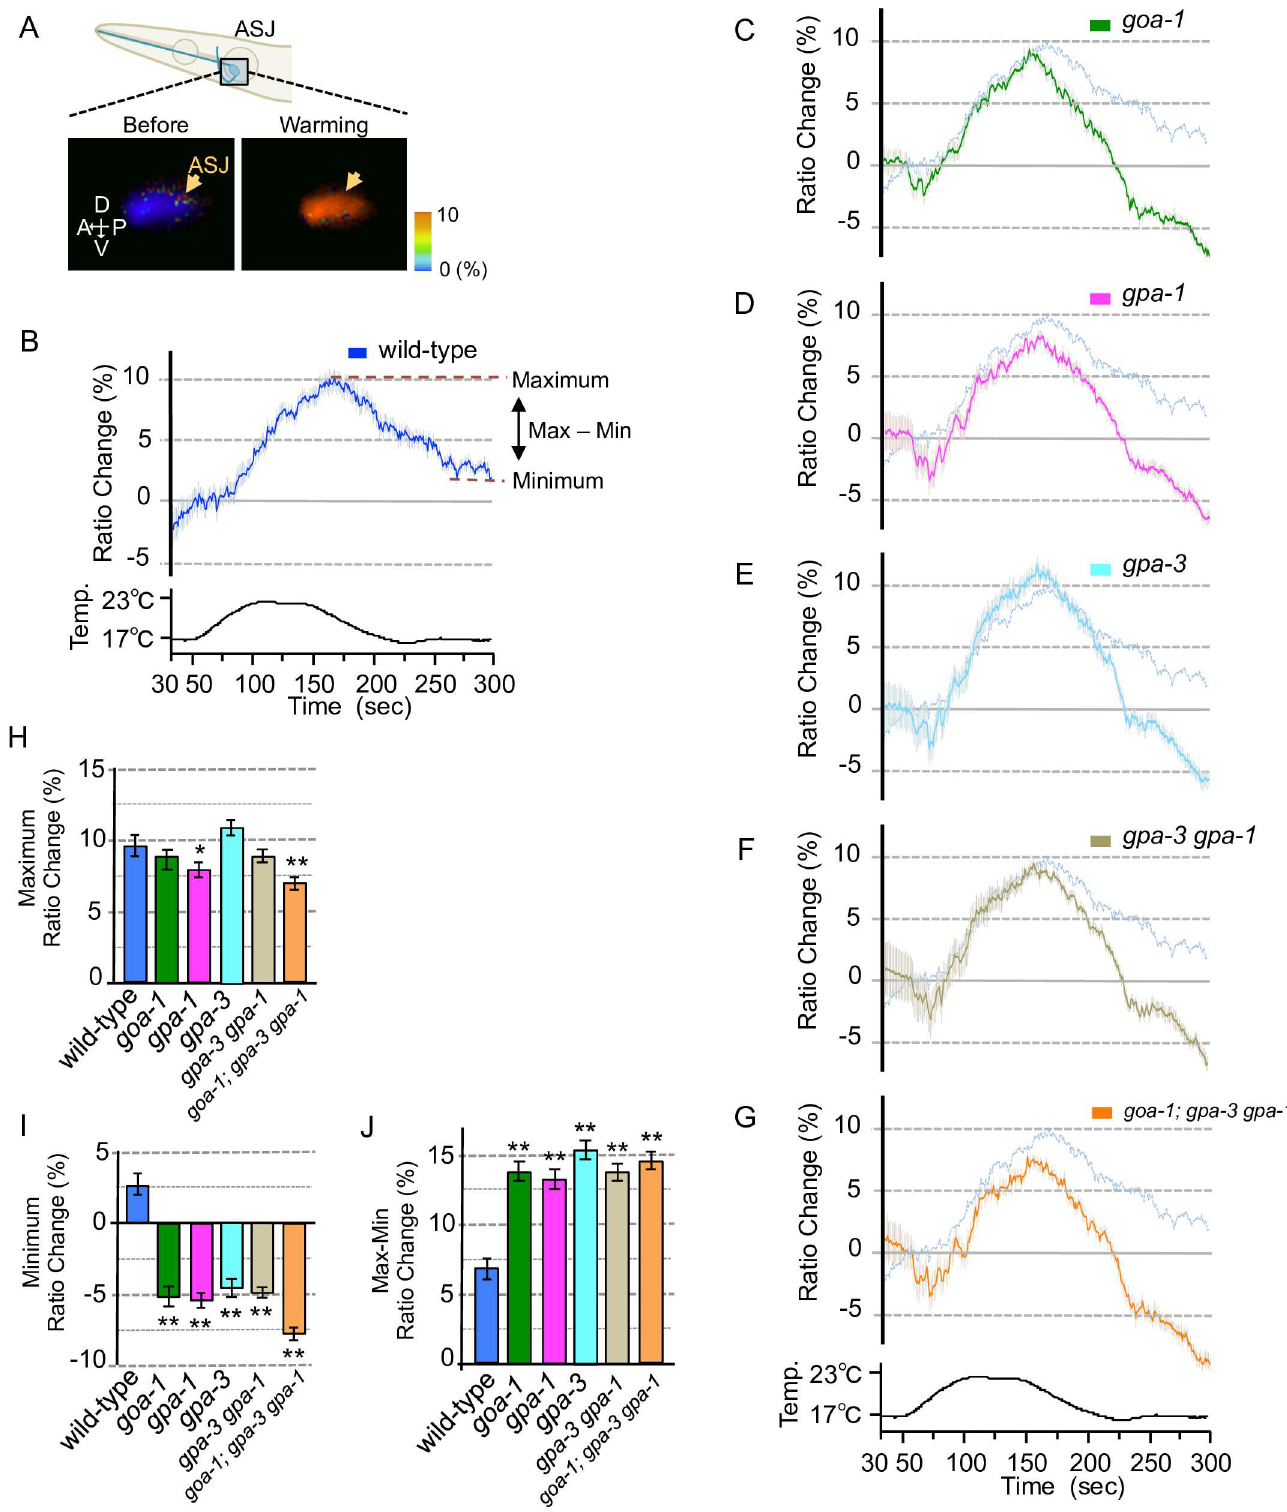
Fig 3. Calcium concentration changes in ASJ of G α mutants with warming stimuli. (A) Wild type with ASJ specific expressionof YC3.60 [ trx- 1p :: yc3 . 60 ] used for calcium imaging. The schematic diagram indicatesan ASJ sensory neuron in the head. The lower pair of images shows the response to a warming stimulus of the ASJ cell body in the 20˚C-cultivated wild type. Arrows indicate ASJ cell body. (B) In vivo calcium imaging of